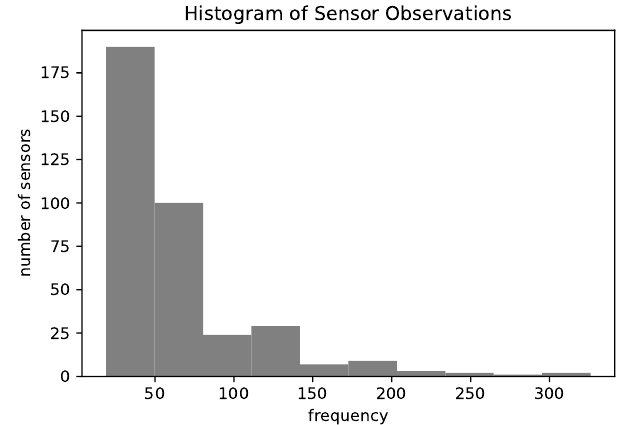
Figure 4. Histogram of the number of observations by each